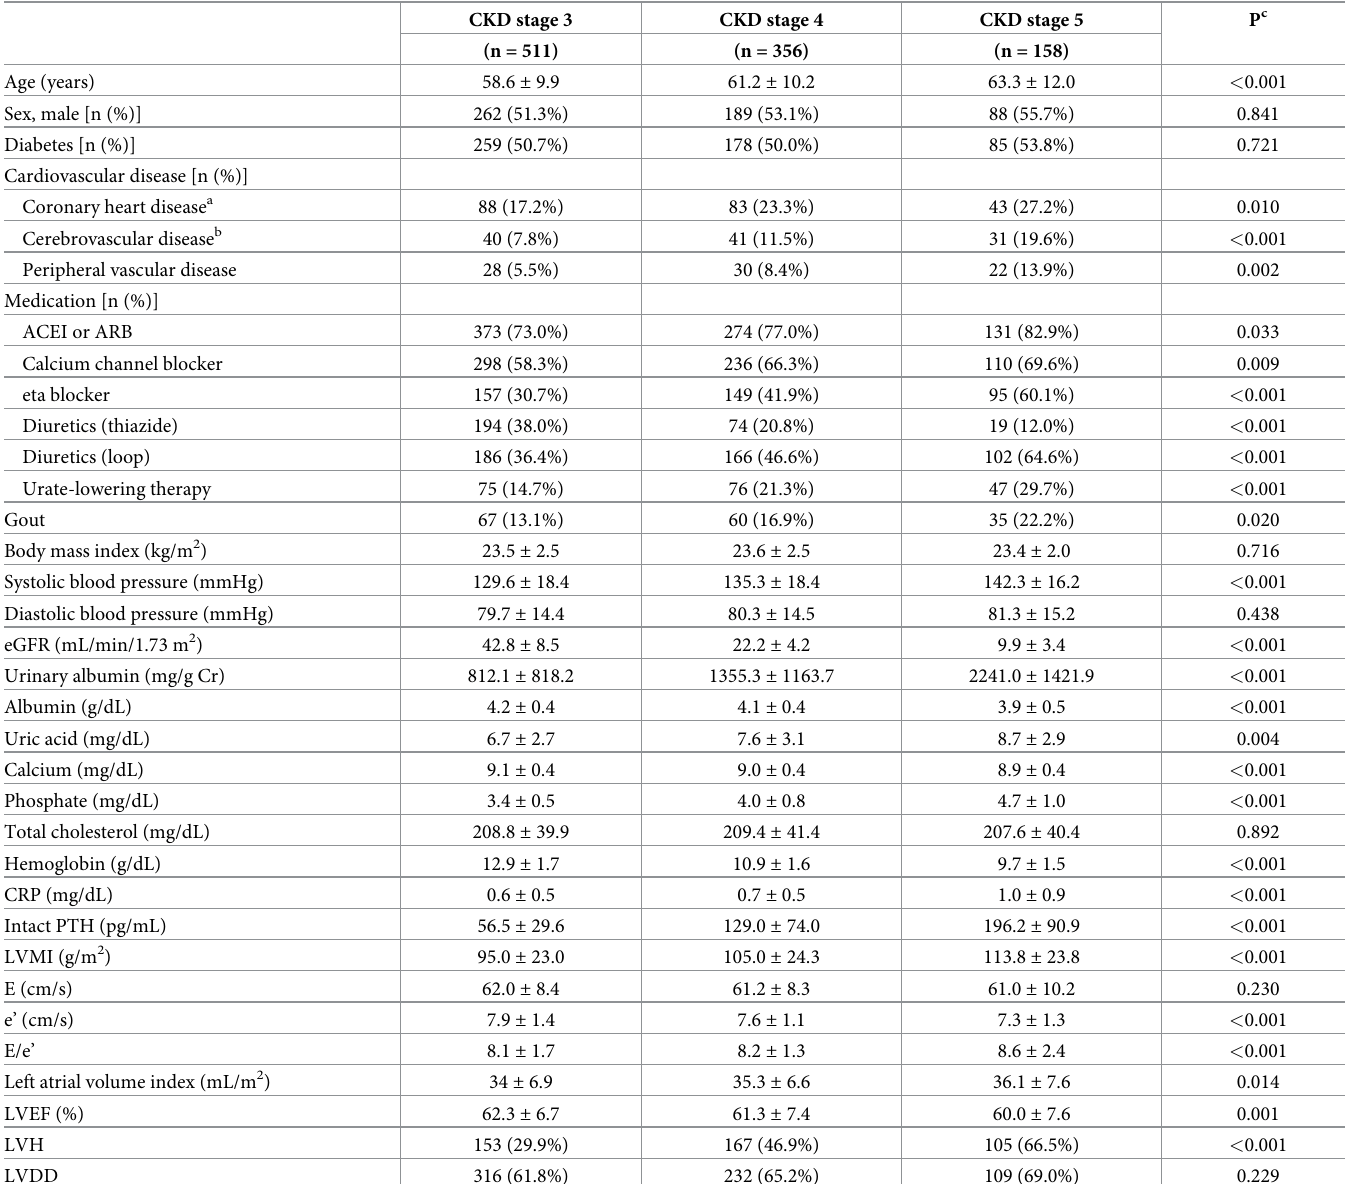
Table 1. Baseline characteristics of the study population according to CKD stage (n =